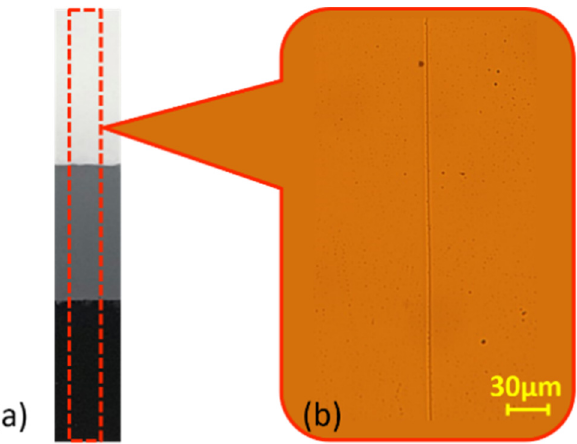
Figure 1. The picture of the sample: ( a ) a scratch was produced on the front surface of the glass slide. Then, the back surface of the glass slide was painted white, gray, and black; ( b ) the microscope image of the scratch.